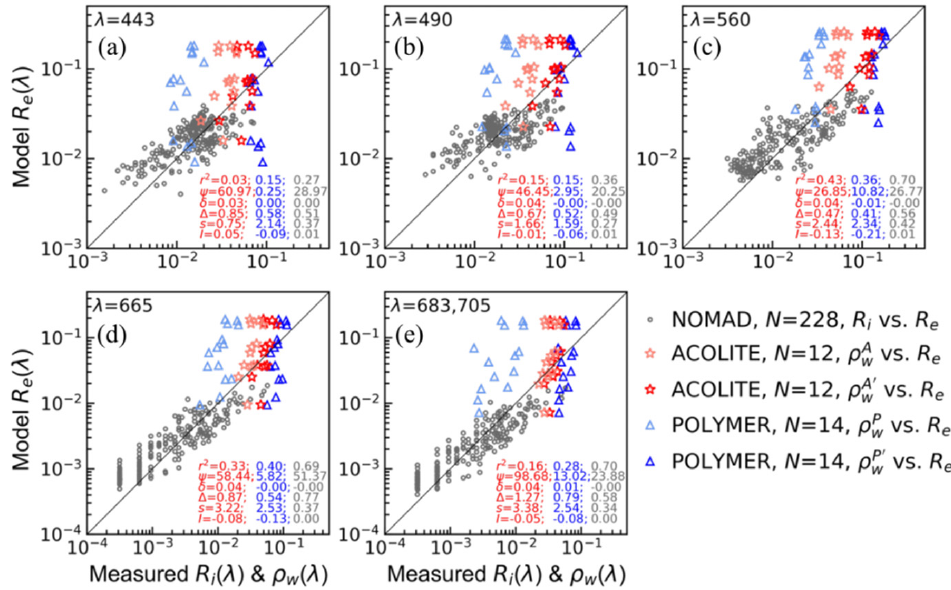
Figure 6. Comparison between the measured and modelled reflectance. The grey circles show the